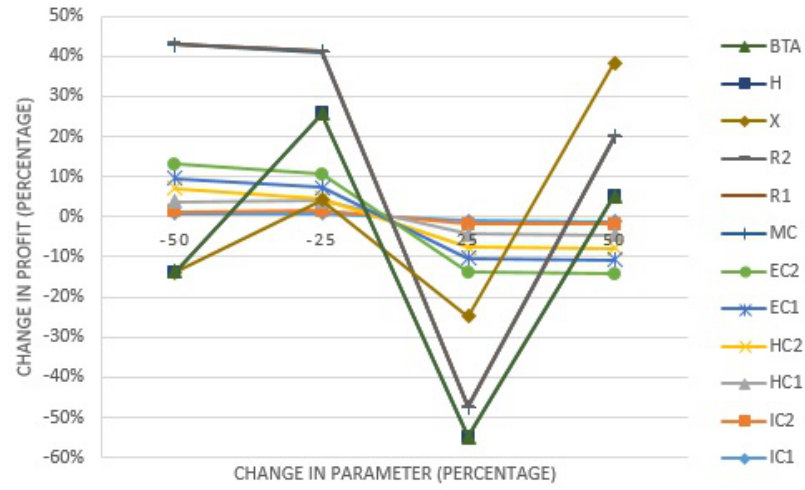
Figure 10. Change of total expected profit (TEP) in percentage versus parametric values in